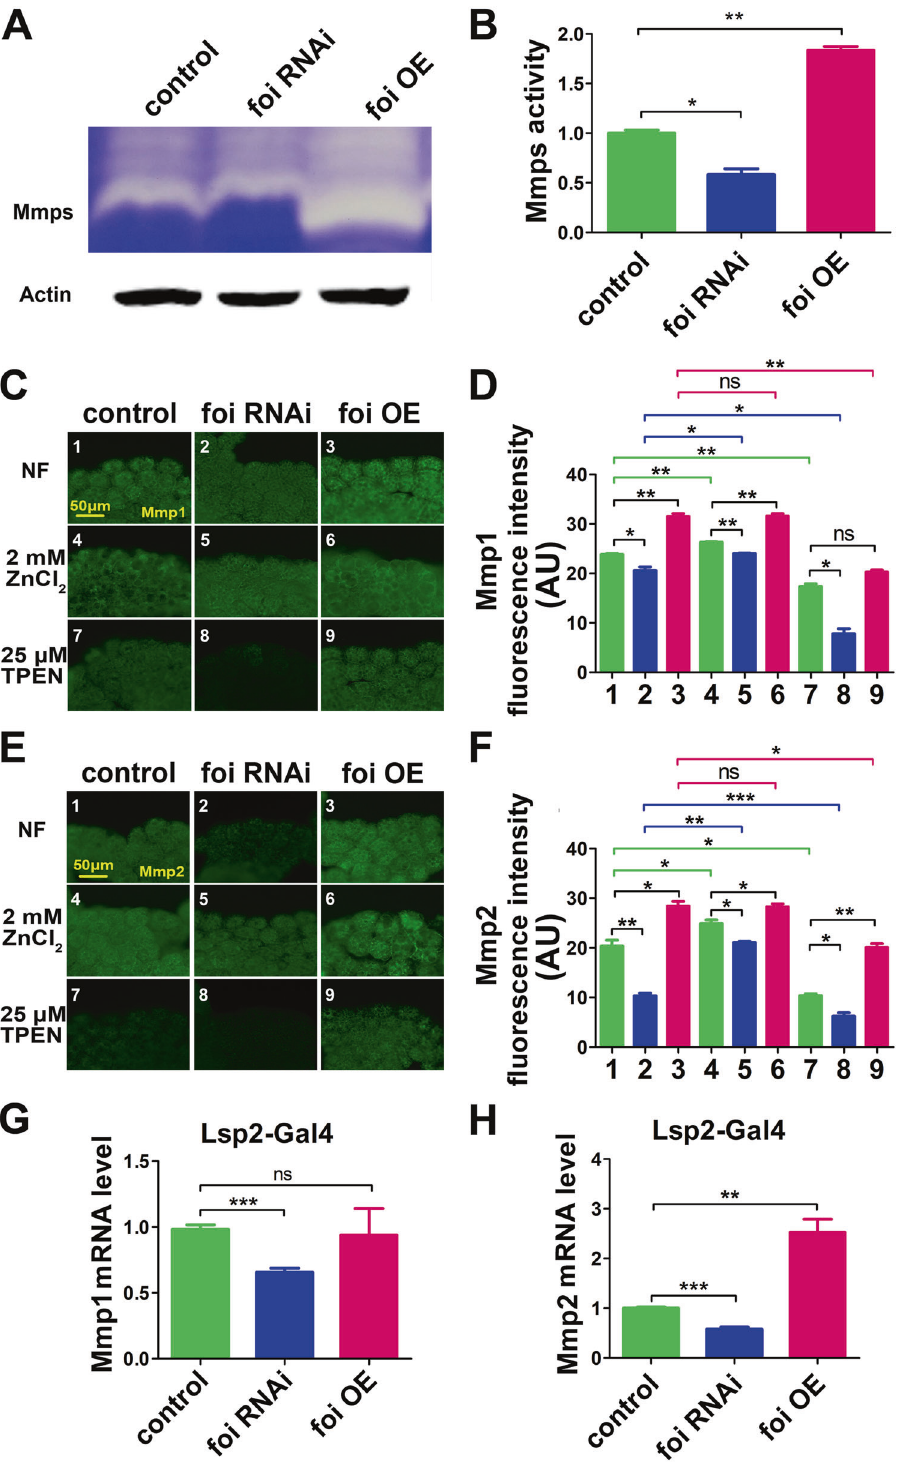
Fig. 4 Zinc affects the enzyme activity, protein and mRNA levels of the two Mmps. A Gelatin zymogram revealed that total Mmp enzyme activity was considerably diminished in Lsp2-Gal4 > foi RNAi larvae while increased in Lsp2-Gal4 > foi OE larvae. B Quantitative measurement of ( A ). C – F Protein levels of both Mmp1 and Mmp2 in the fat body were reduced in Lsp2-Gal4 > foi RNAi larvae while increased in Lsp2-Gal4 > foi OE larvae. Dietary zinc supplementation was able to elevate the expression of Mmps, whereas zinc chelator TPEN can reduce their expression. G , H Both Mmp1 and Mmp2 mRNA levels were signi fi cantly down-regulated in Lsp2-Gal4 > foi RNAi larvae, whereas a dramatically up-regulated Mmp2 mRNA level could be detected in Lsp2-Gal4 > foi OE larvae. w1118 fl ies driven by Lsp2-Gal4 serve as a blank control. All the experiments were conducted independently at least for 3 times. ns: not signi fi cant, * P < 0.05, ** P < 0.01, *** P < 0.001, two-tailed Student ’ s t